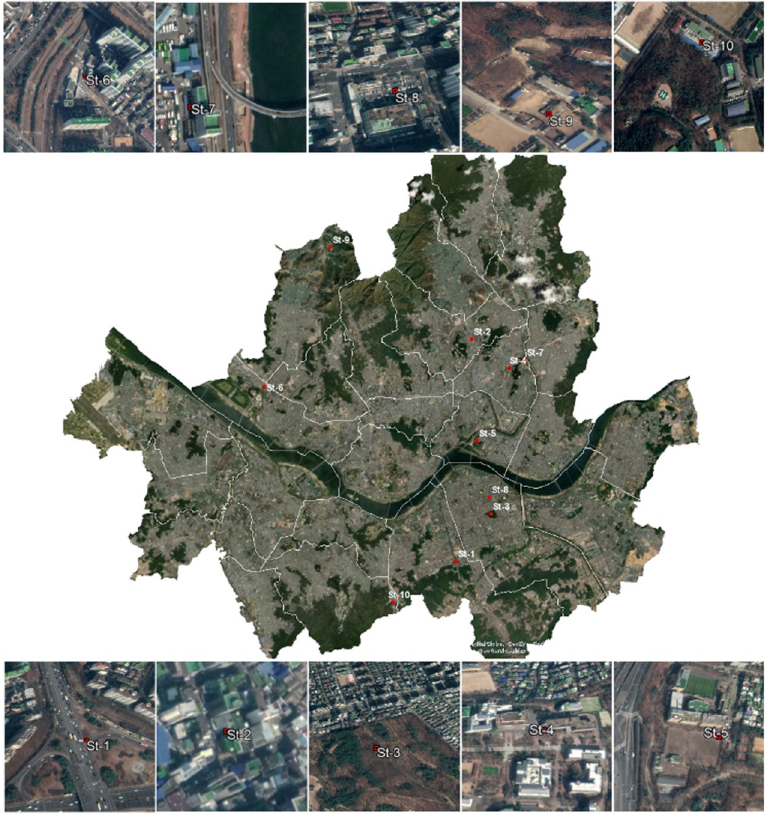
Fig 1. Geographical locations of the station within Seoul city’s boundaries (Contains information from OpenStreetMap and OpenStreetMap Foundation, which is made available under the Open Database License).